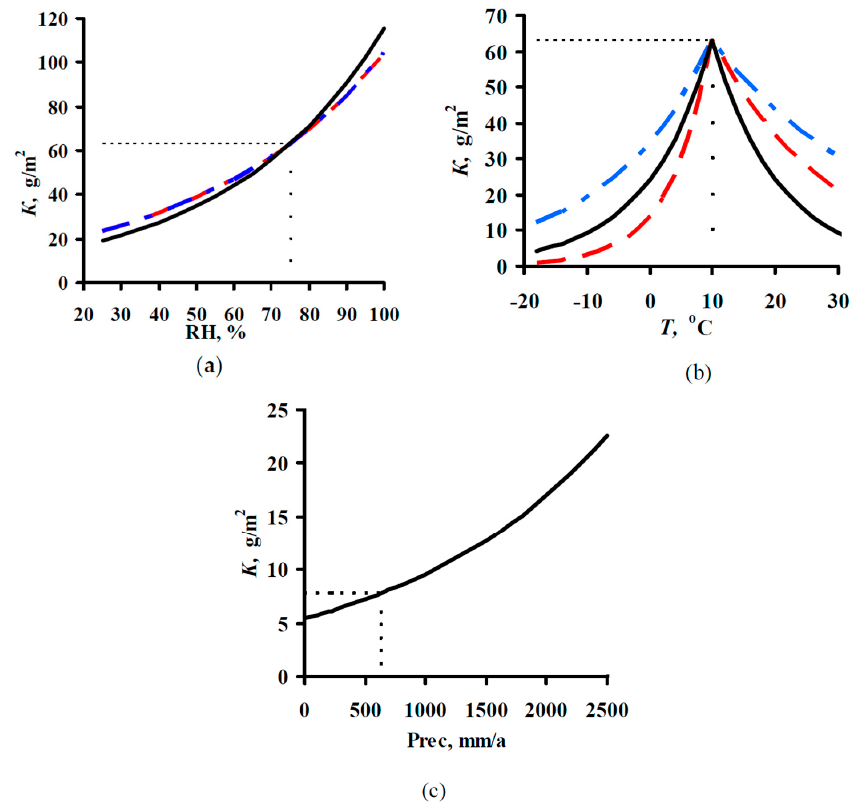
Figure 7. Variation of K for carbon steel vs. relative humidity ( а ), temperature ( b ). and Prec ( с ) with account for the values of the DRF coefficients. ▬▬ by the New DRF; ▬ ▬ by the Standard DRF; ▬ • ▬ by the Unified DRF.